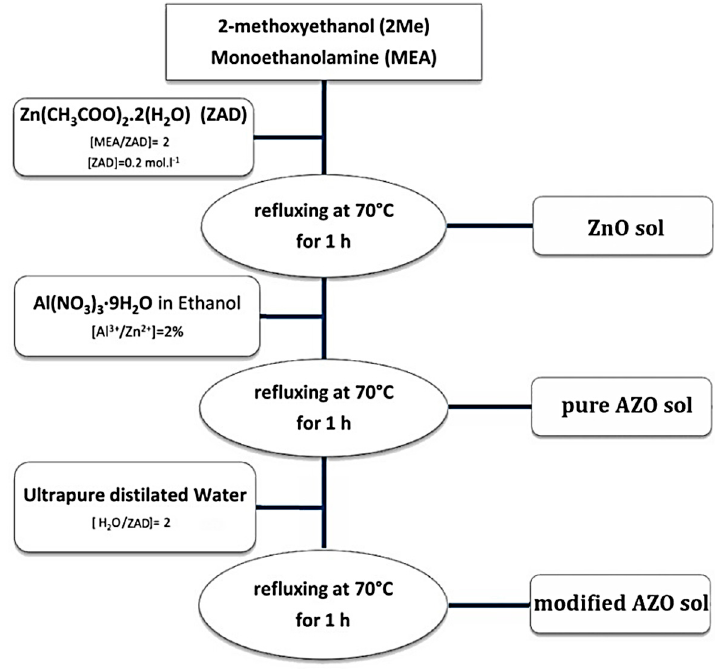
Figure 1. The flowchart summarizing the sol’s preparation steps.